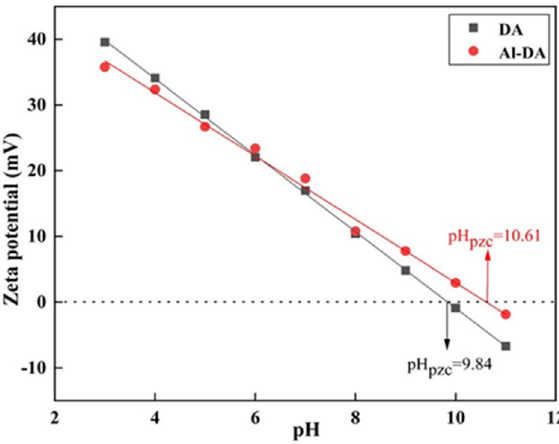
Figure 5. Zeta potential of DA and Al-DA at different pH